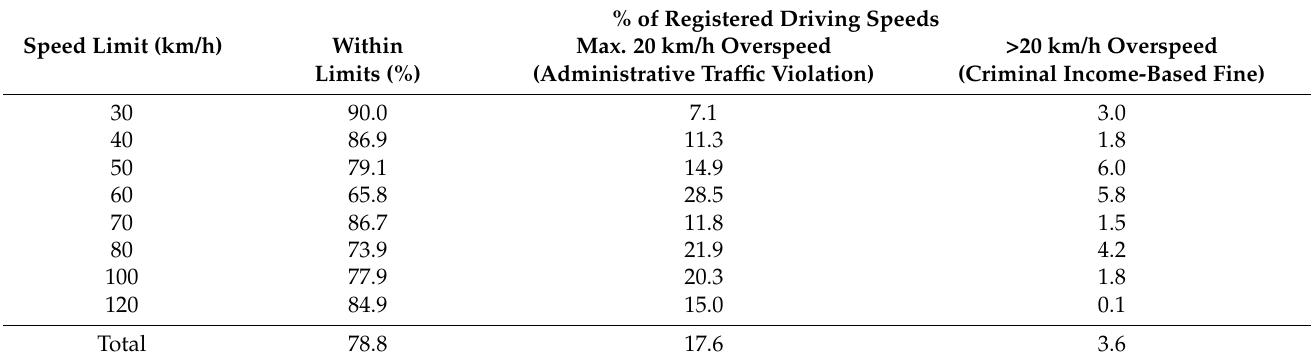
Table 3. Distribution of registered driving speeds in non-urgent ambulance D-missions by Finnish traffic violation legislation.